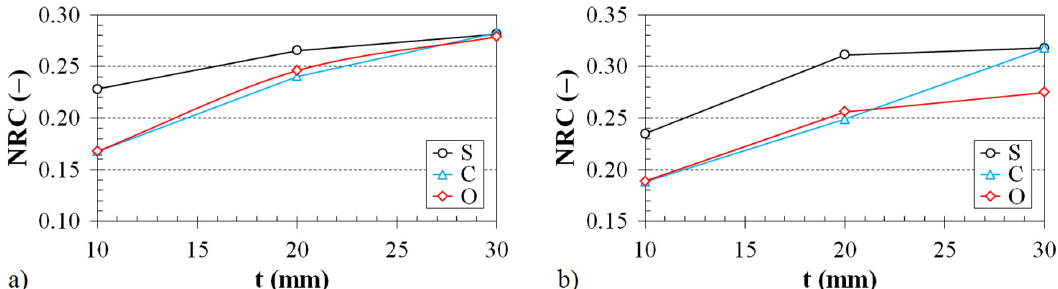
Figure 9. Effect of the material structure on the noise reduction coefficient vs. the material thickness dependencies for the investigated ABS samples placed at a distance from the wall inside the impedance tube: ( a ) 30 mm and ( b ) 75 mm.